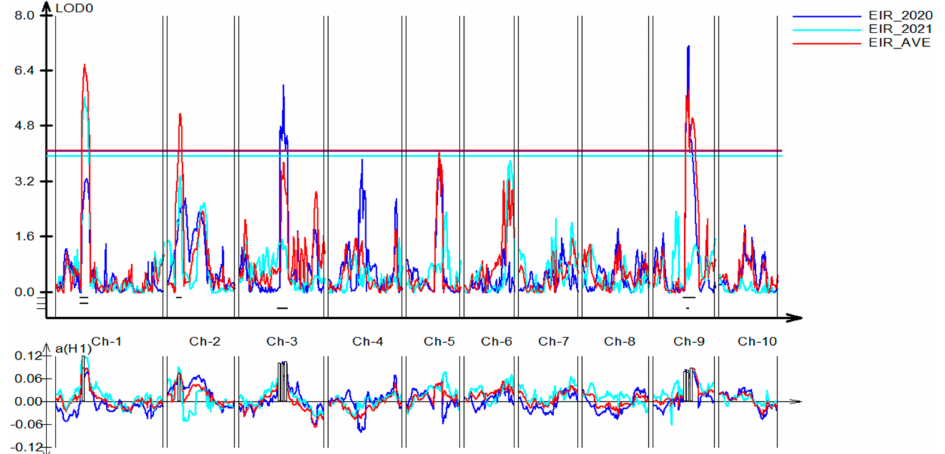
Figure 3. Detection of quantitative trait loci (QTLs) for the EIR in the segregating population. The log of odds (LOD) and additive effect, a(H1), plotted against the ten chromosomes were used for linkage analysis. The horizontal lines represent the threshold values for detecting authentic